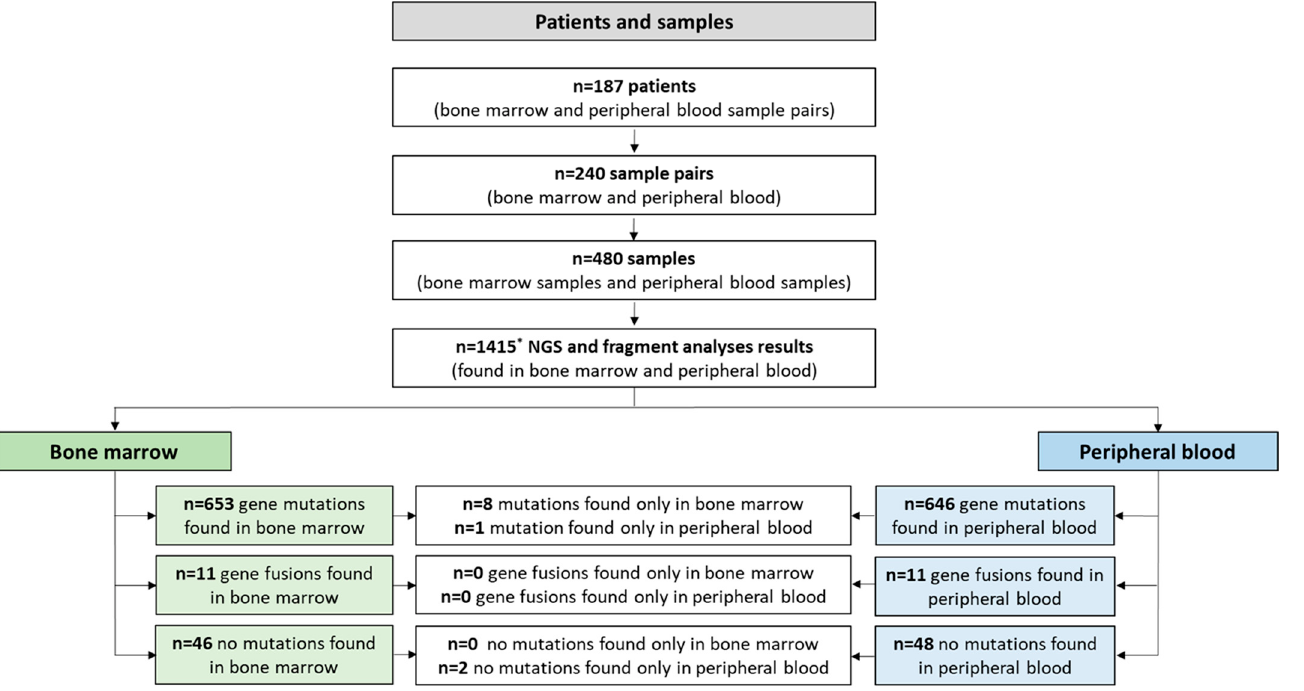
Figure 1. Numbers of patients, samples and mutations. * Total reported molecular results (n = 1415) consist of: 1321 pathogenic variants (8 fragment analysis, 1313 NGS); 94 samples with no mutations. Patient characteristics on the day of the bone marrow assessment are shown in Table